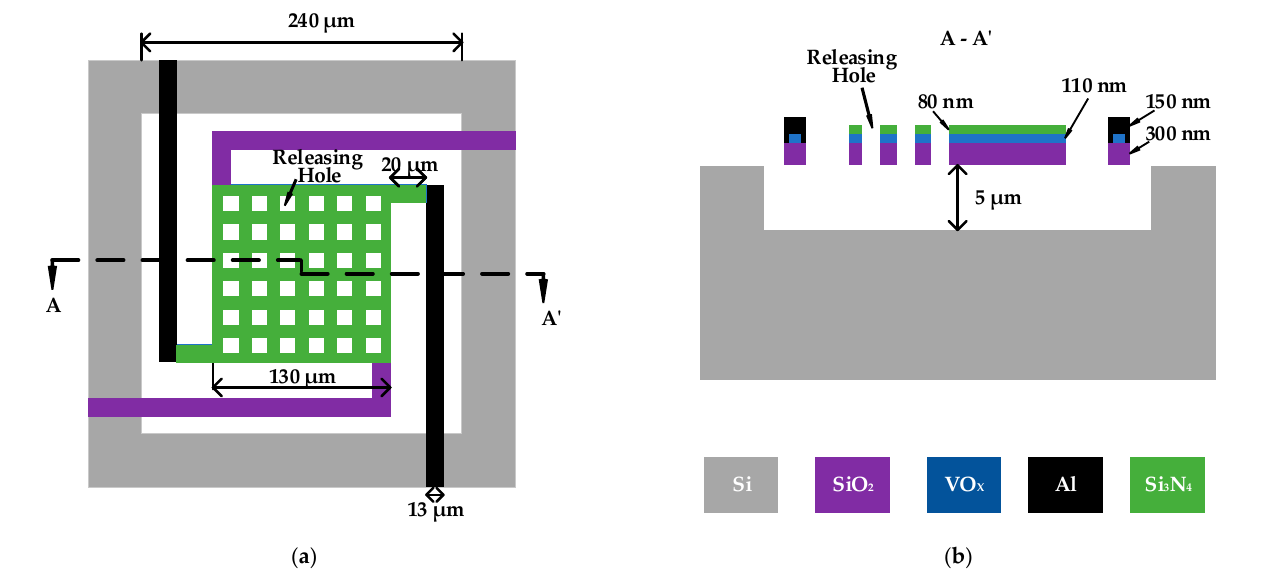
Figure 3. Schematic diagram of the Pirani gauge. ( a ) Top view of the Pirani gauge; ( b ) AA’ cross- section view of the Pirani gauge.